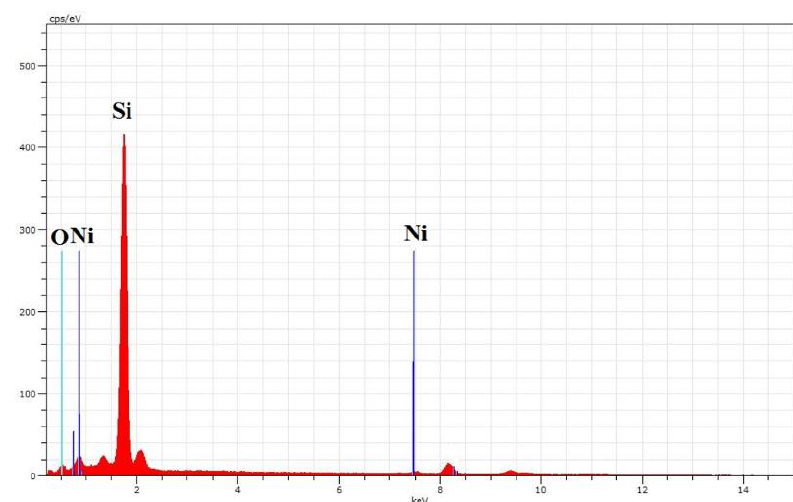
Figure 1. EDS spectrum of the NiO film on the Si substrate.